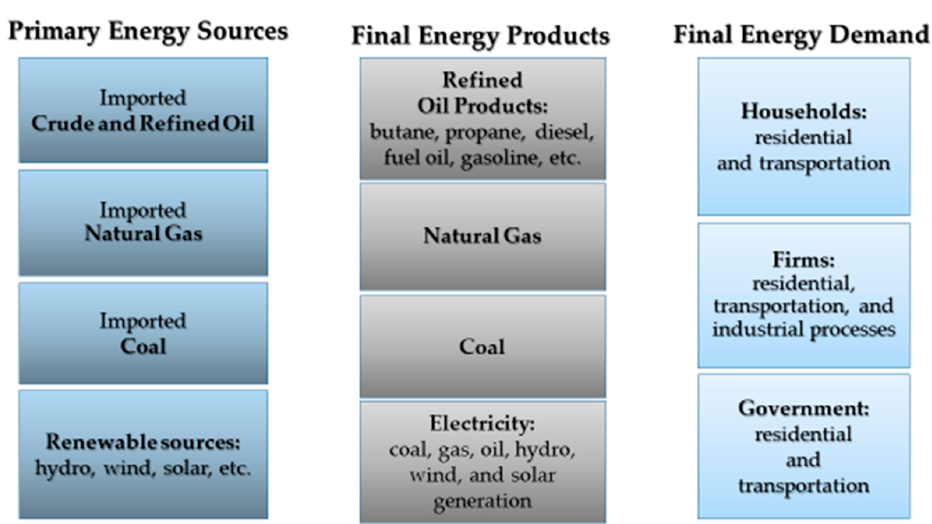
Figure 2. The Energy Module.